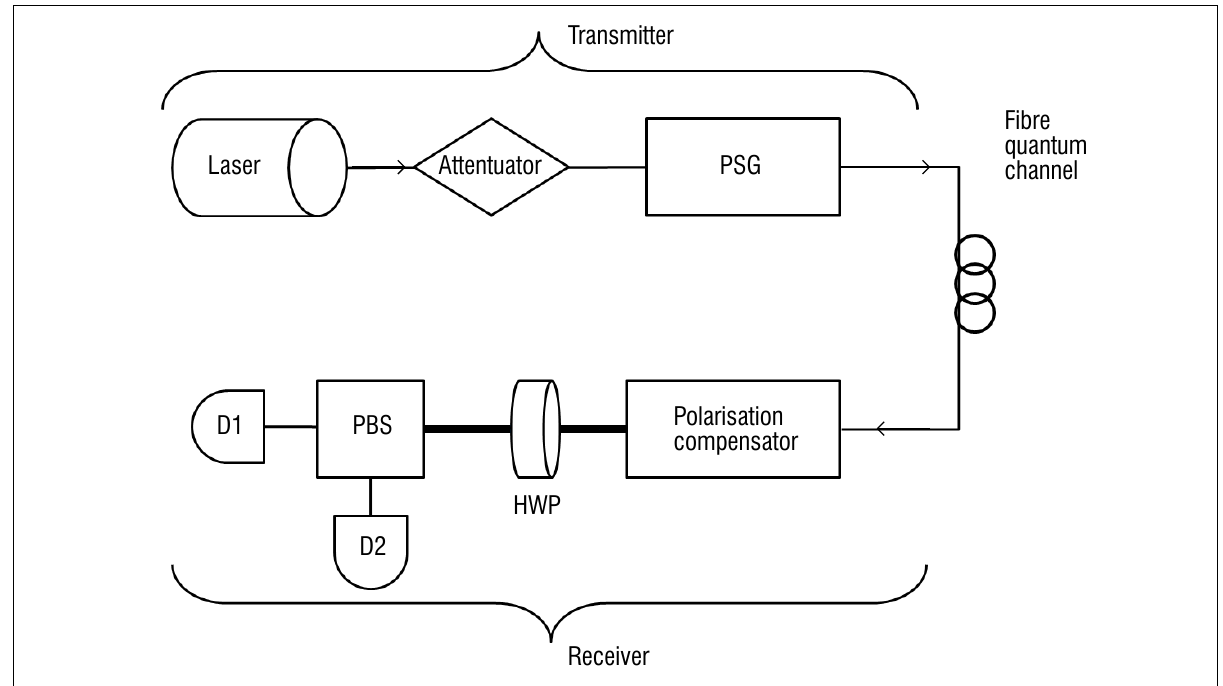
Figure 3: The proposed set-up for a polarisation-encoded quantum key distribution scheme. The laser pulses are first passed through an optical attenuator, which creates pseudo-single photons. Each photon is then assigned a state of polarisation with the polarisation state generator (PSG) and is transmitted through the quantum channel to the receiver. The receiver then uses the polarisation compensator to correct for changes in polarisation. A half-wave plate (HWP) is used to select the basis in which the receiver will measure each photon and, finally, the photons are separated at a polarisation beam splitter (PBS) to be measured at one of two detectors (D1 or D2). The bold lines in the diagram indicate polarisation-maintaining